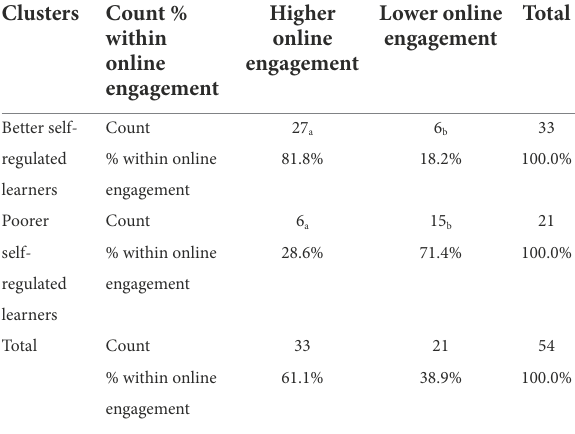
TABLE 5 Results of the cross-tabulation. Clusters Count % within online engagement